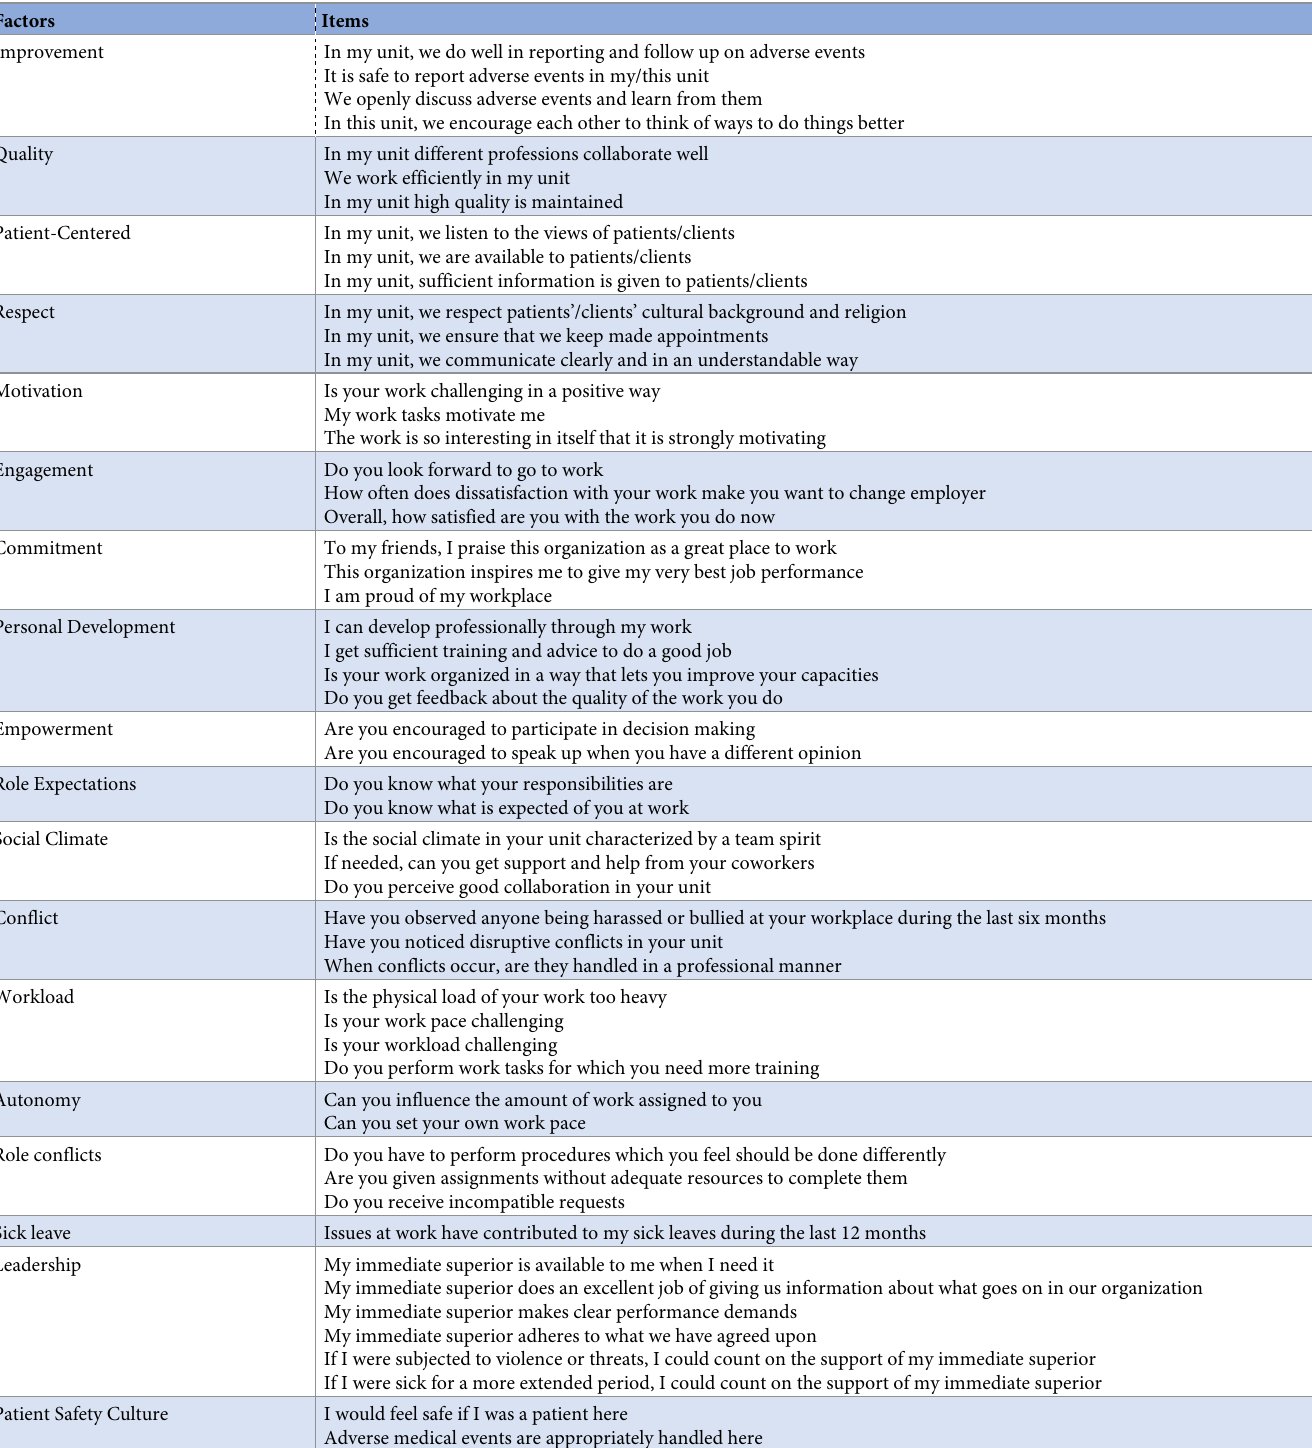
Table 2. Work Environment Survey (WES) factors and